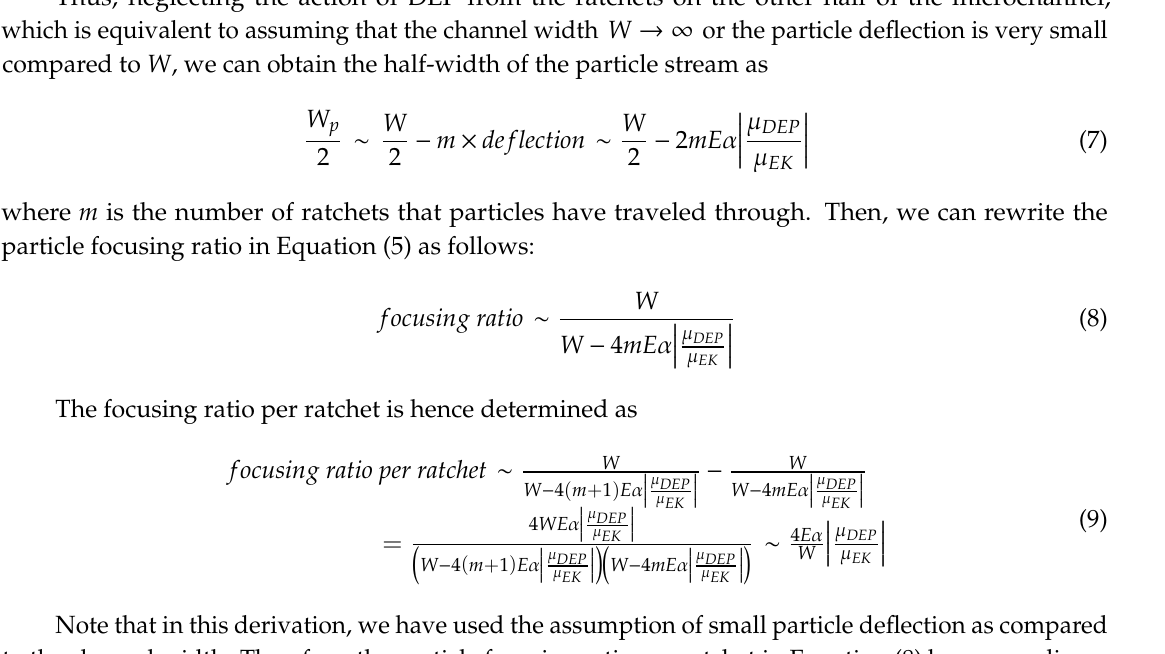
Figure 4. Effect of the electric field on the dielectrophoretic focusing of 5 μ m diameter particles in the symmetric ratchet microchannel: ( a ) Comparison of the experimentally obtained and numerically predicted (top half of the left- and right-most images only) particle trajectories (traveling from left to right) at varying locations of the microchannel under 125 (bottom row), 250 (middle row), and 500 V / cm (top row) electric fields, respectively; ( b ) Comparison of the experimentally measured (symbols with error bars) and numerically calculated (curves) particle focusing ratios among the three electric fields.